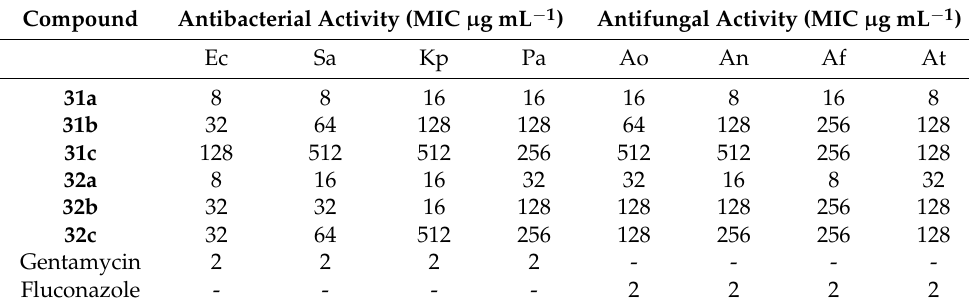
Table 2. Antibacterial and antifungal activities of the compounds 28a – 28h . Compound